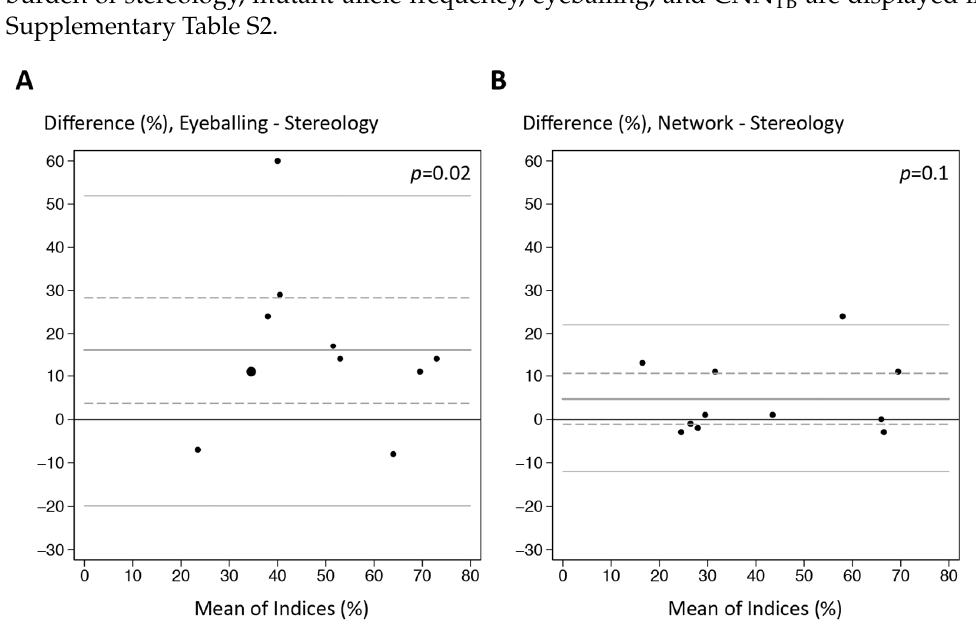
Figure 6. Bland–Altman plots that compare the tumor burden of stereological counts with either the pathologist’s eyeballing of routine diagnosis ( A ) or the automated calculation of the convolutional neural network CNN TB ( B ). The 95% limits of agreement (thin grey lines) and the mean difference (thick grey line) with associated 95% confidence intervals (hatched grey lines) are shown. Enlarged dot in ( A ) resembles two samples with the same percentage levels.